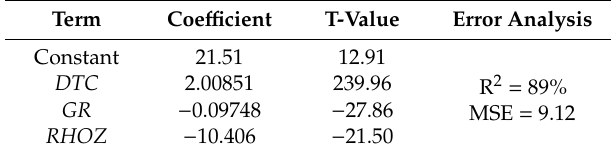
Table 3. Multiple linear regression model properties.